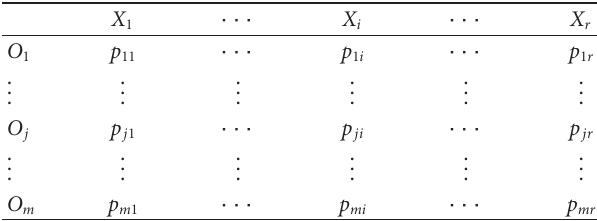
Table 1: Schema of a dataset.